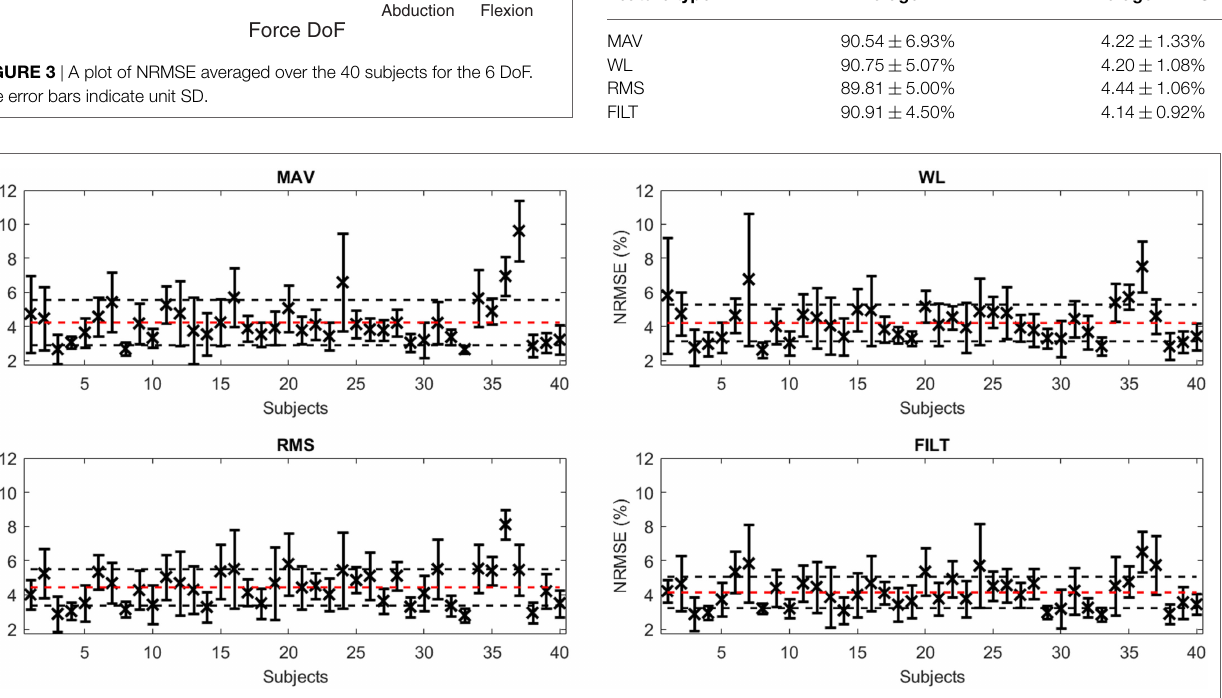
Table 4 . Overall, the FILT FE has the best performance with the